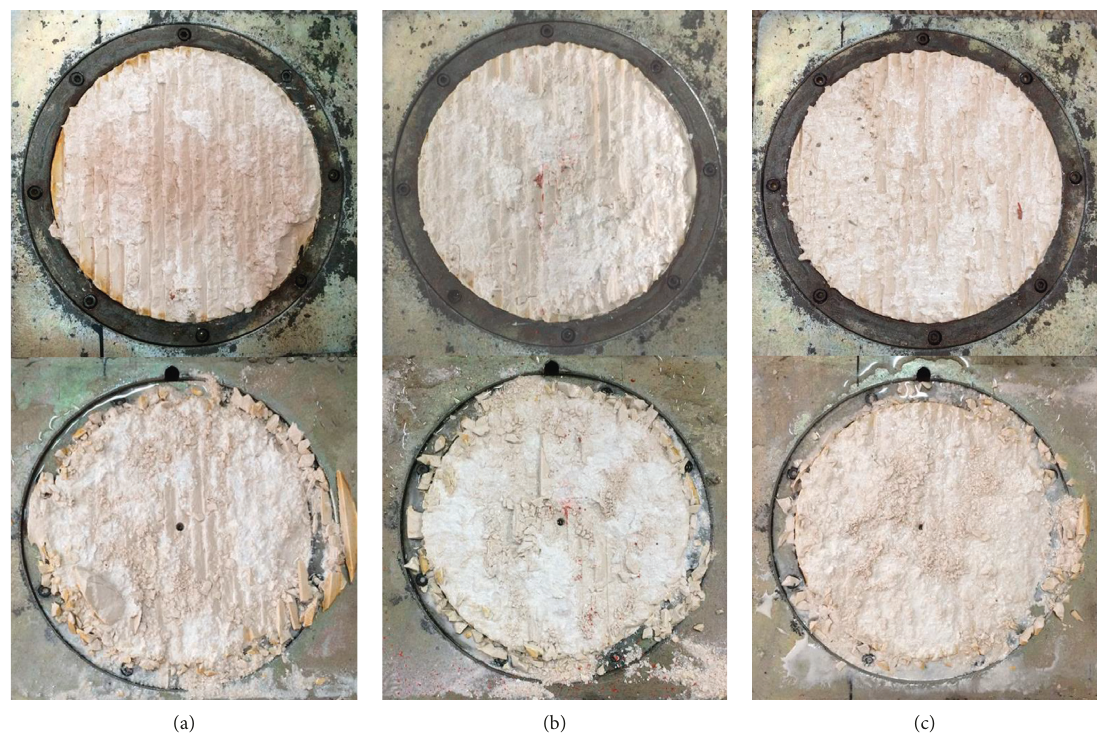
Figure 7: Group A fracture surfaces after the shear tests. (a) Case 1. (b) Case 2. (c) Case 3.